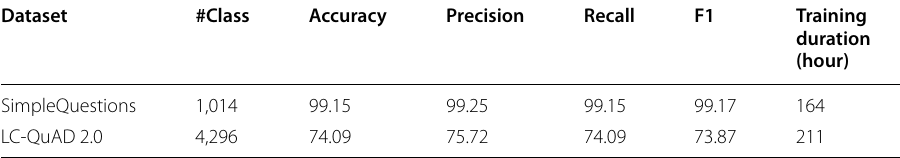
Table 4 The performance of entity detection task using UDP-based feature (in percent) Dataset #Class Accuracy Precision Recall F1 SimpleQuestions LC-QuAD 2.0